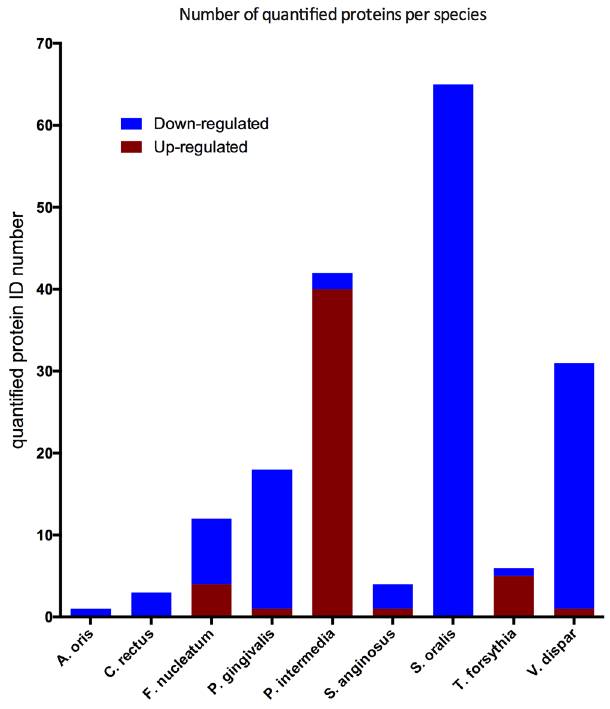
Figure 4. Number of differentially regulated proteins from each species. Regulation trends of label-free quantified proteins are shown based on whether they are down- (blue) or up- (red) regulated in relation to the present of A. geminatus in the biofilm. A significant (p < 0.05) difference of 2-fold in protein levels was defined as